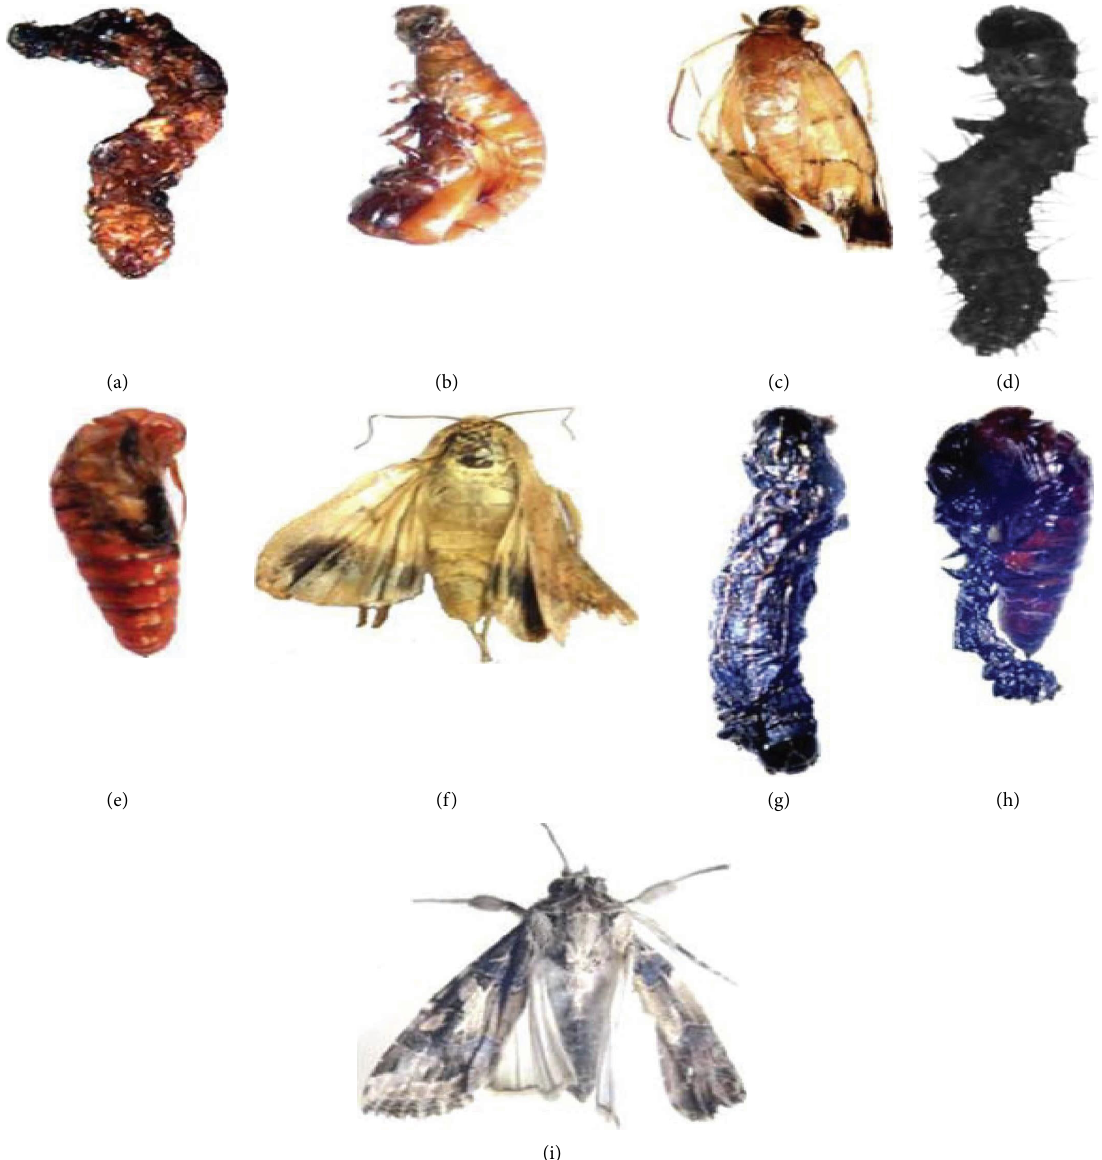
Figure 4: Defects in the metamorphosis of some Lepidopteran insects larvae, following treatment with 0.5 ppm of neem: Cnaphalocrocis medinalis larval, pupal, and adult defects (a)–(c), Helicoverpa armigera larval, pupal, and adult defects (d)–(f), and Spodoptera litura larval, pupal, and adult defects (g)–(i)